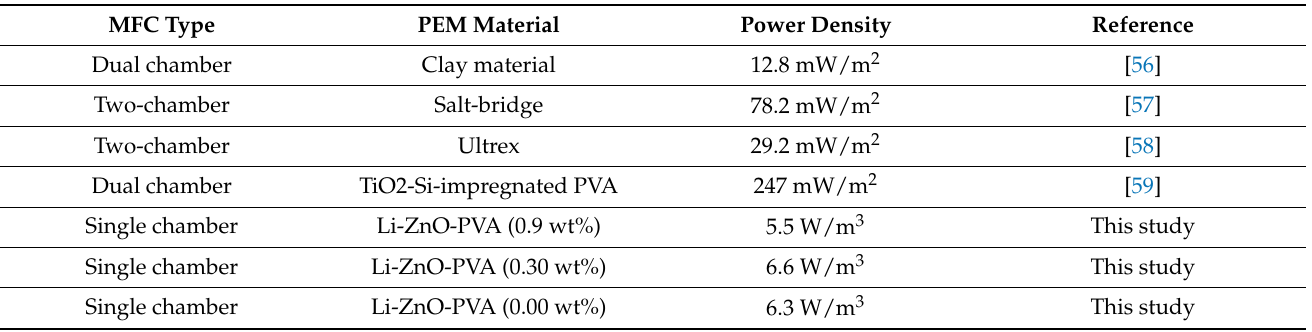
Table 4. Comparison of performance between CEMs used in the present study and prior